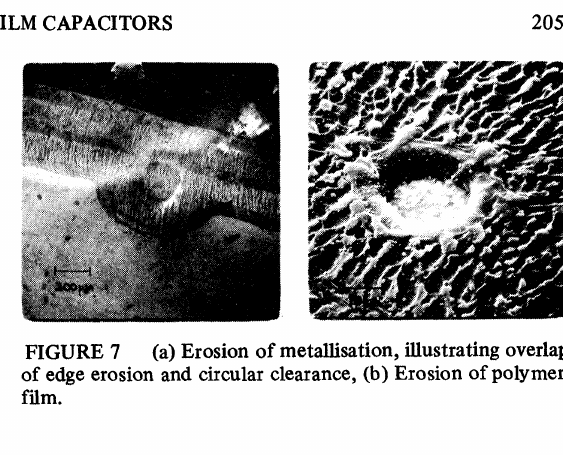
FIGURE 7 (a) Erosion of metallisation, illustrating overlap of edge erosion and circular clearance, (b) Erosion of polymer